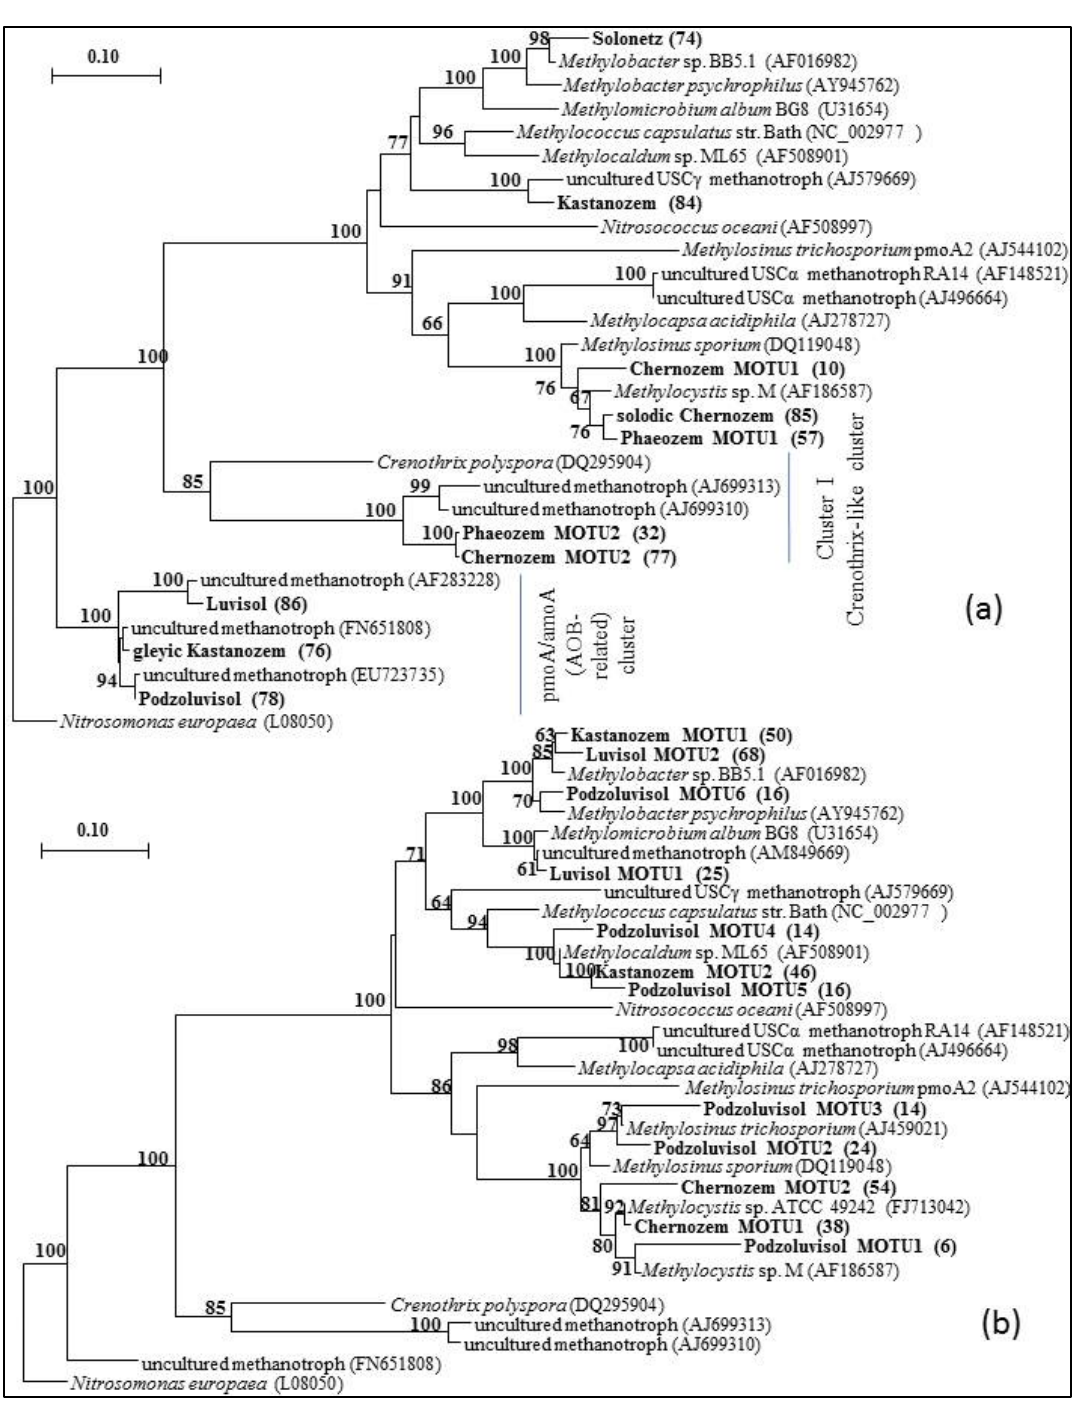
Figure 2. Phylogenetic placement of amino acids sequences determined in this study; ( a ) unmanaged soils, ( b ) managed soils. The numbers given on branches are frequencies (>60%) with which a given branch appeared in 100 bootstrap replications. The scale indicates the number of expected substitutions accumulated per site. The tree is rooted with Nitrosomonas europaea . GenBank accession numbers and number of sequences corresponding to each MOTU are given in